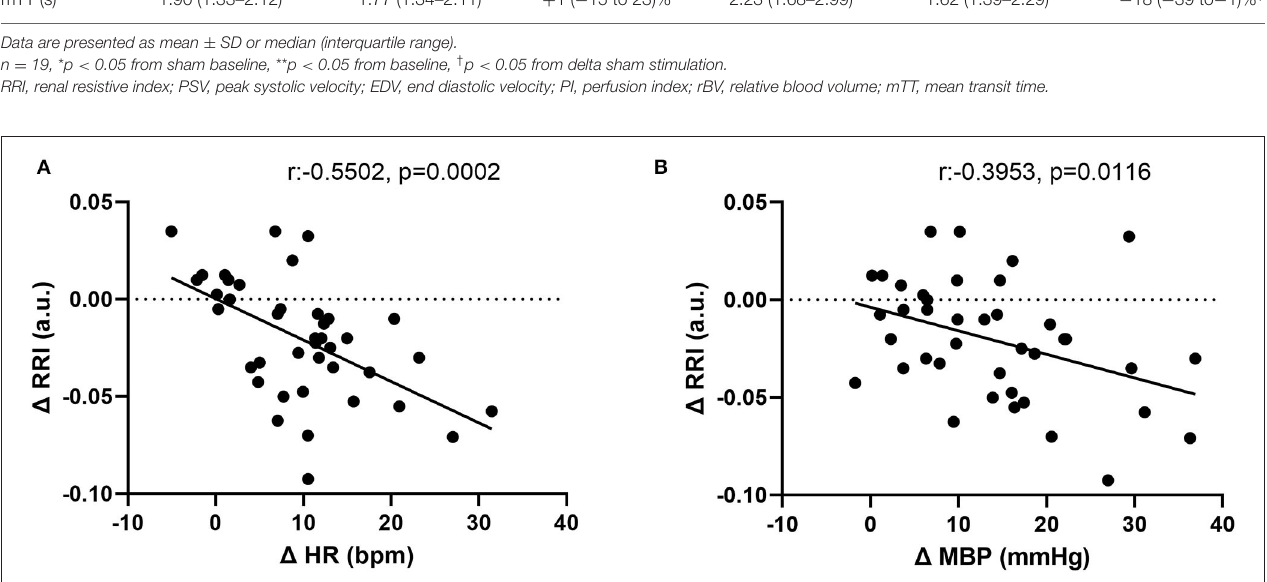
FIGURE 5 | Correlation between changes in (A) renal resistive index (RRI) and heart rate (HR). (B) RRI and mean blood pressure